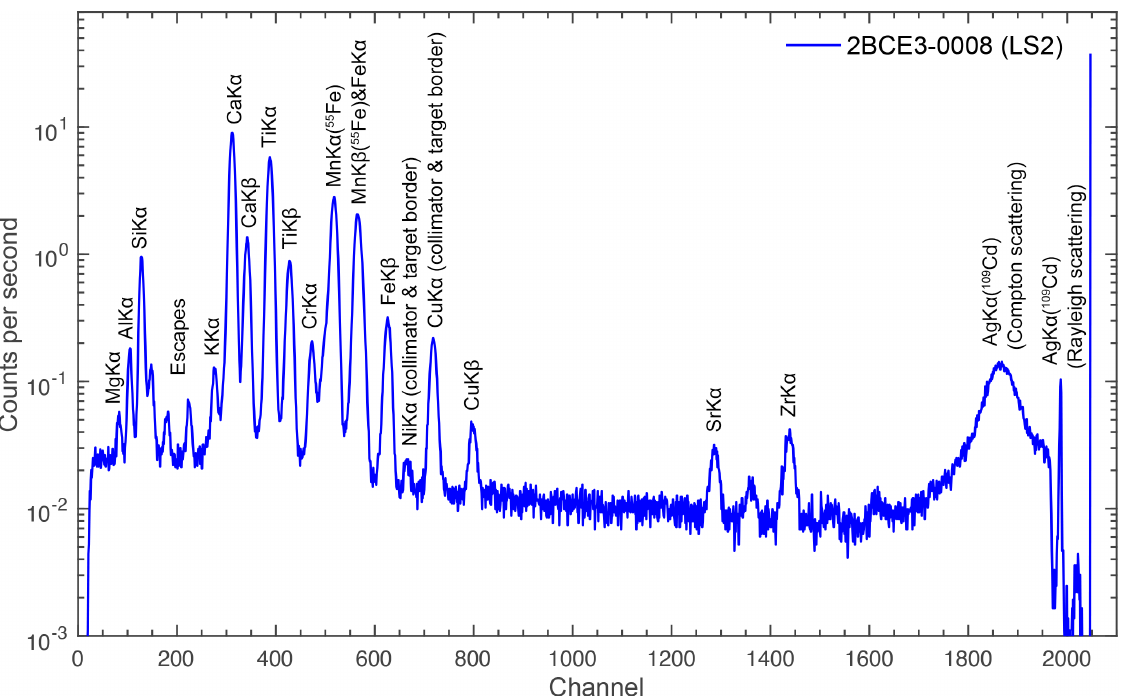
Figure 5. APXS spectrum of lunar soil sample (LS2) measured on 14 January 2014 (UTC). NiK α peak is partly from materials in the collimator. Table 4. Summary of the measurements with the identifier, location and time in this study.